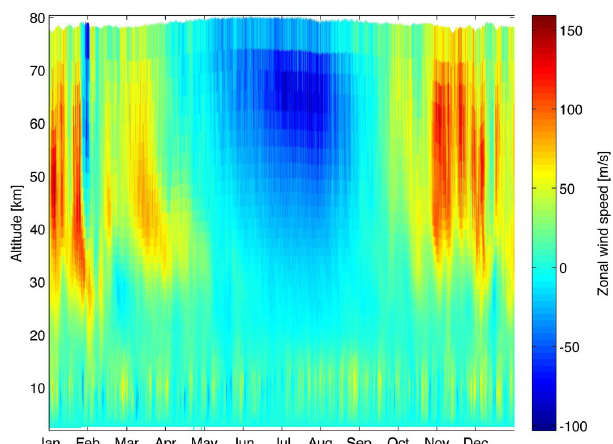
Fig. 1. Zonal wind over Bern (46 ◦ 57 0 N, 7 ◦ 26 0 E) throughout the year 2010 according to ECMWF operational analysis data. Note the abrupt change in wind direction at the end of January above 50km